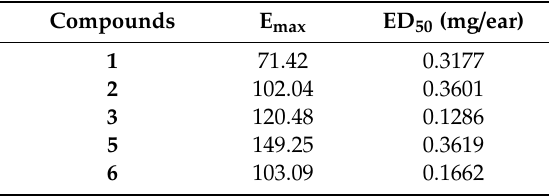
Table 4. Anti-inflammatory activity compounds from B. conferta .